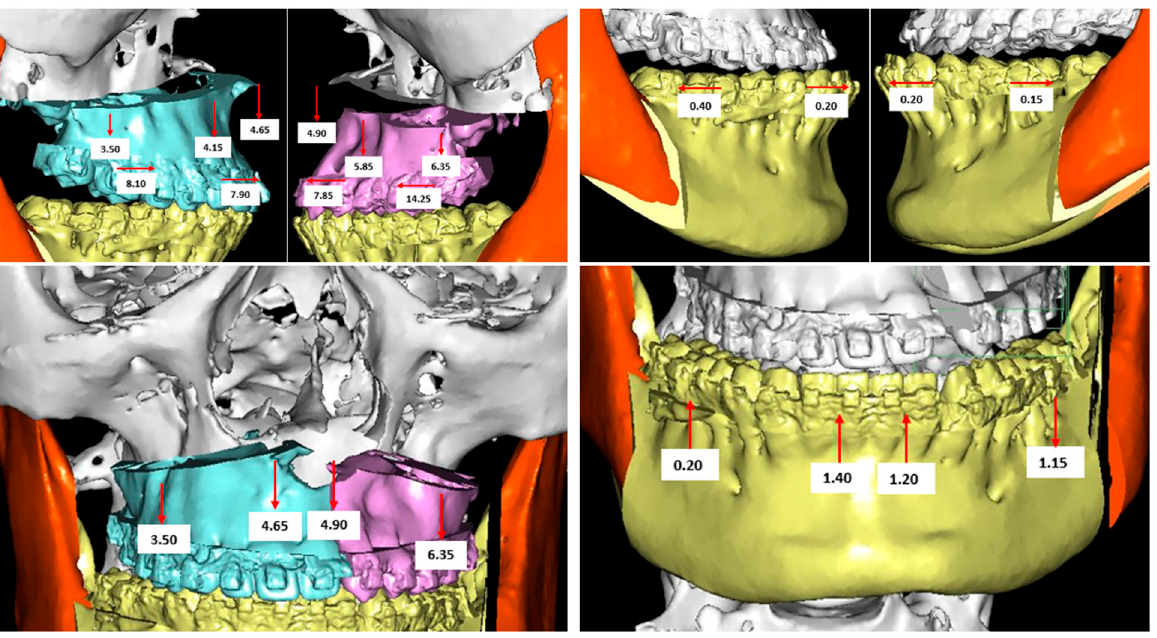
Figure 1. Digital surgical planning of a cleft lip and palate (CLP) patient performed with the DDS-Pro software .